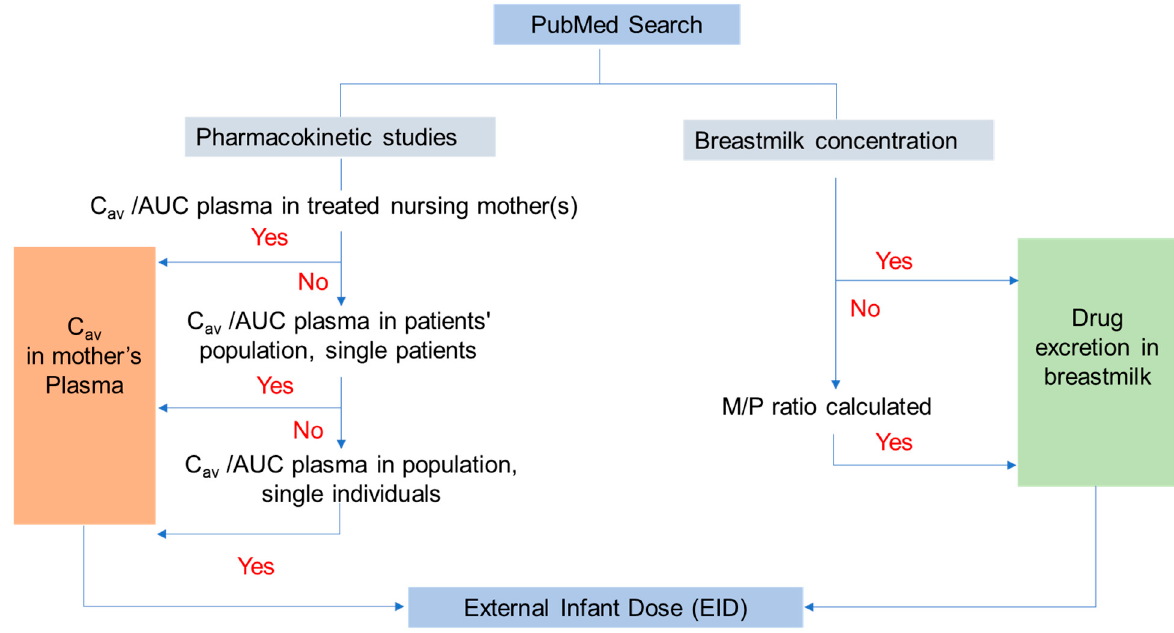
Figure 3. A schematic flowchart showing the search strategy and milk data collection from PubMed. C av , average plasma concentration; AUC, area under the concentration–time curve.